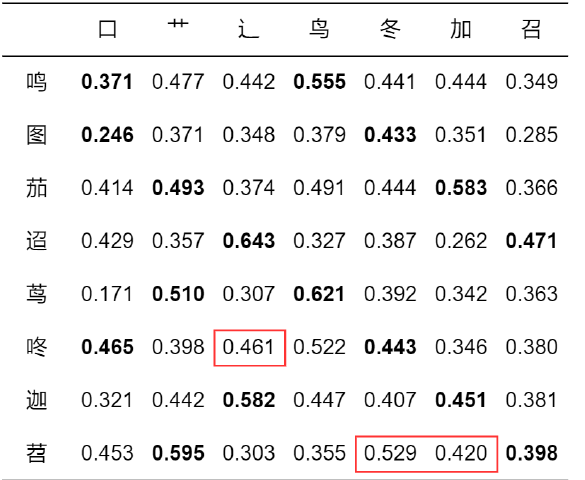
Figure 12. The similarity between the Chinese characters and their radical parts. Bold numbers indicate the cosine similarity between Chinese characters and their corresponding radical components, and those enclosed in red boxes represent some